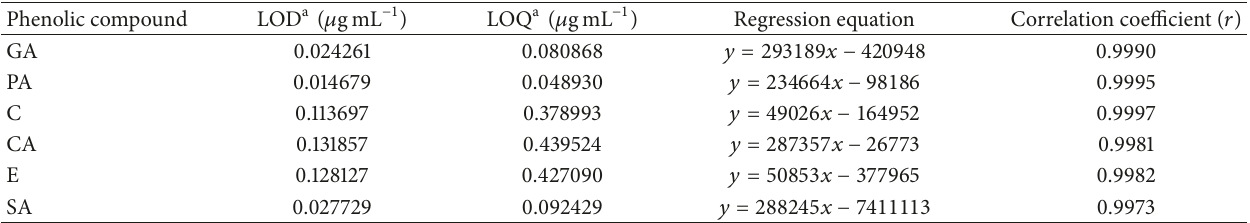
Table 4: Methodological data for quantitative determination of phenolic standards analysed by RP-HPLC.